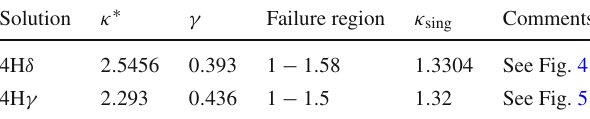
Table 2 Choptuik exponents for the two last branches of solutions of the 4 dimensional hyperbolic class